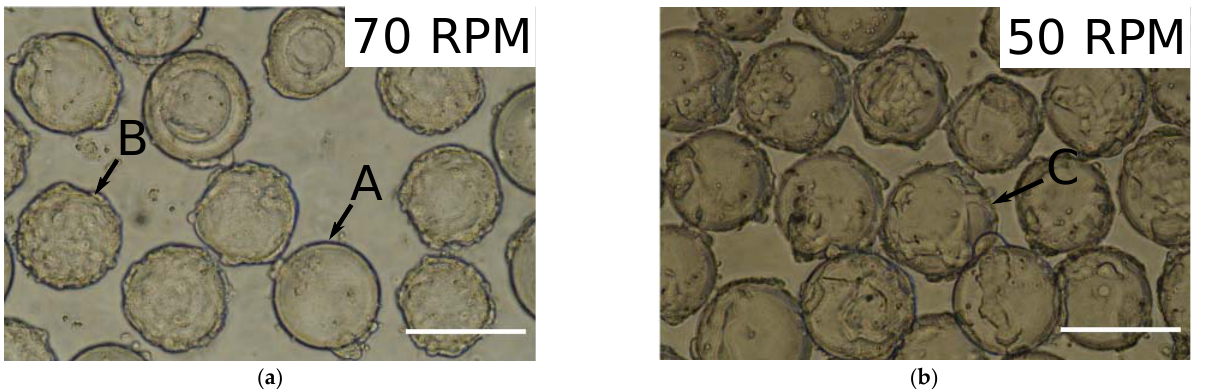
Figure 1. Pictures comparing the cell distribution on microcarriers of HEK293T cells inoculated at different agitation rates and a density of 0.64 × 10 6 cells mL − 1 ; the scale bar represents 200 µm. Arrows point at microcarrier bare from cells (A), fully confluent (B), and with homogenous cell distribution ( C ). ( a ) 70 RPM; ( b ) 50 RPM.